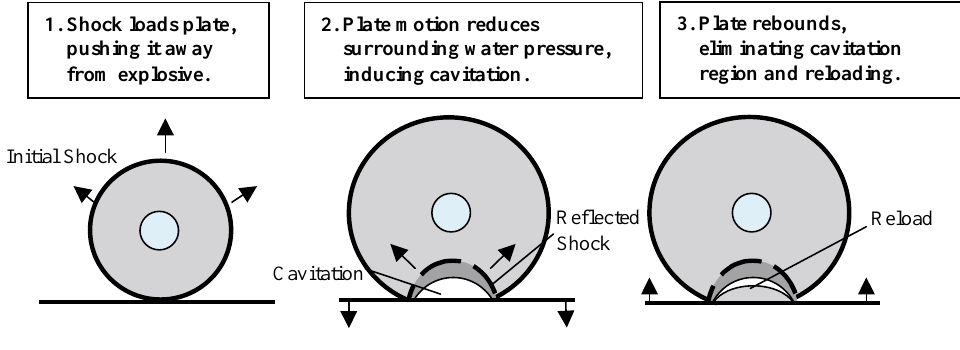
Fig. 1. Traditional view of fluid-structure interaction.